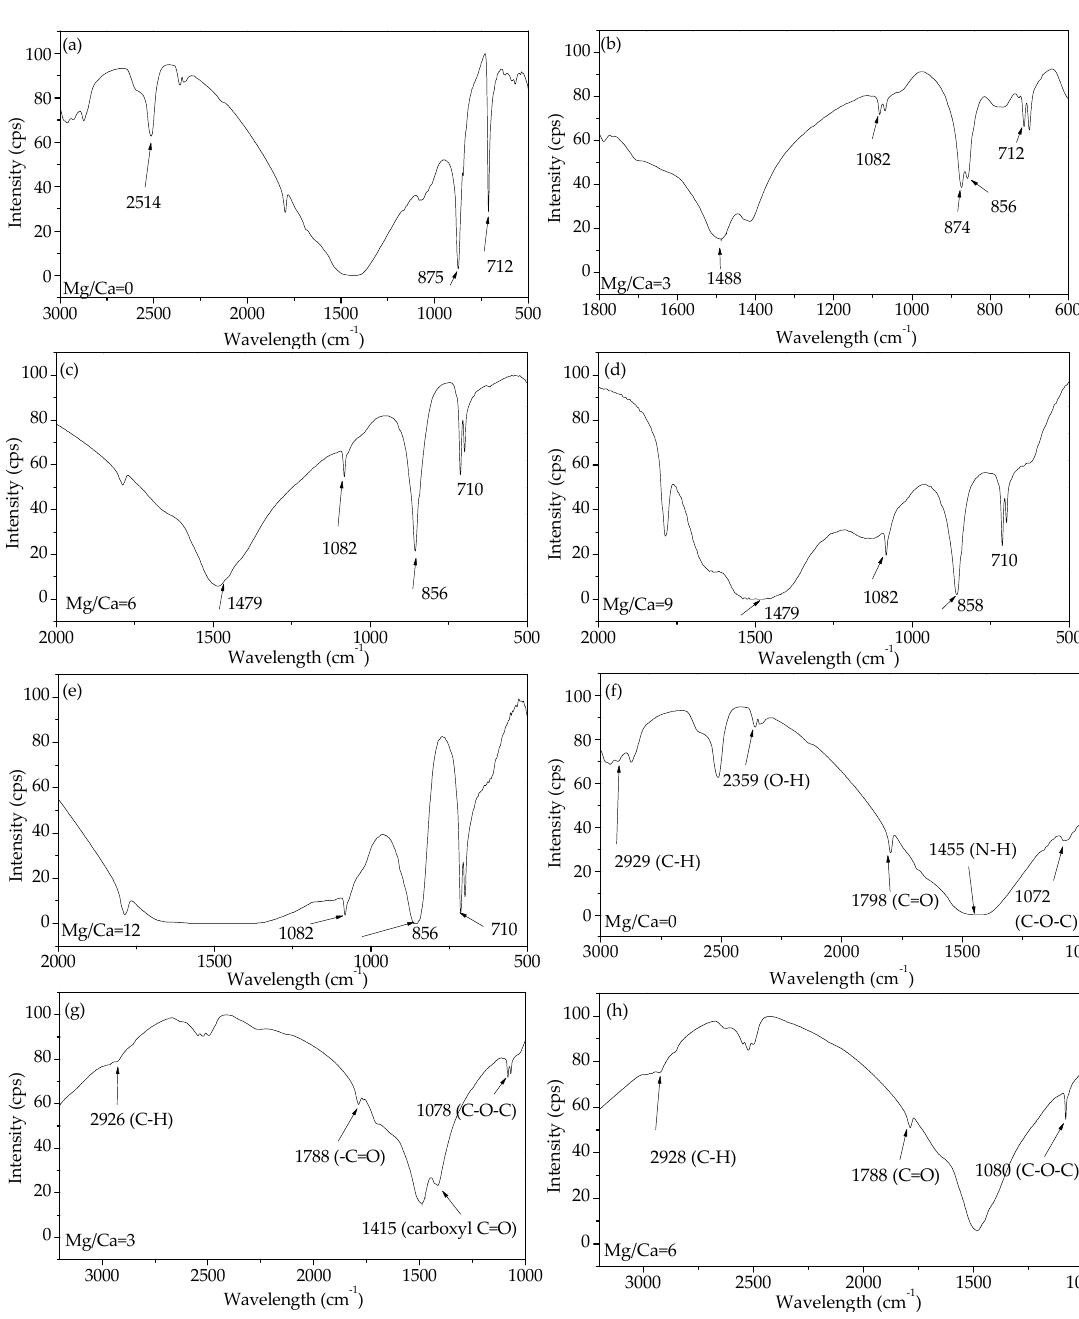
Figure 6. Fourier transform infrared spectroscopy analyses (FTIR) of the mineral precipitates cultured for 14 days.